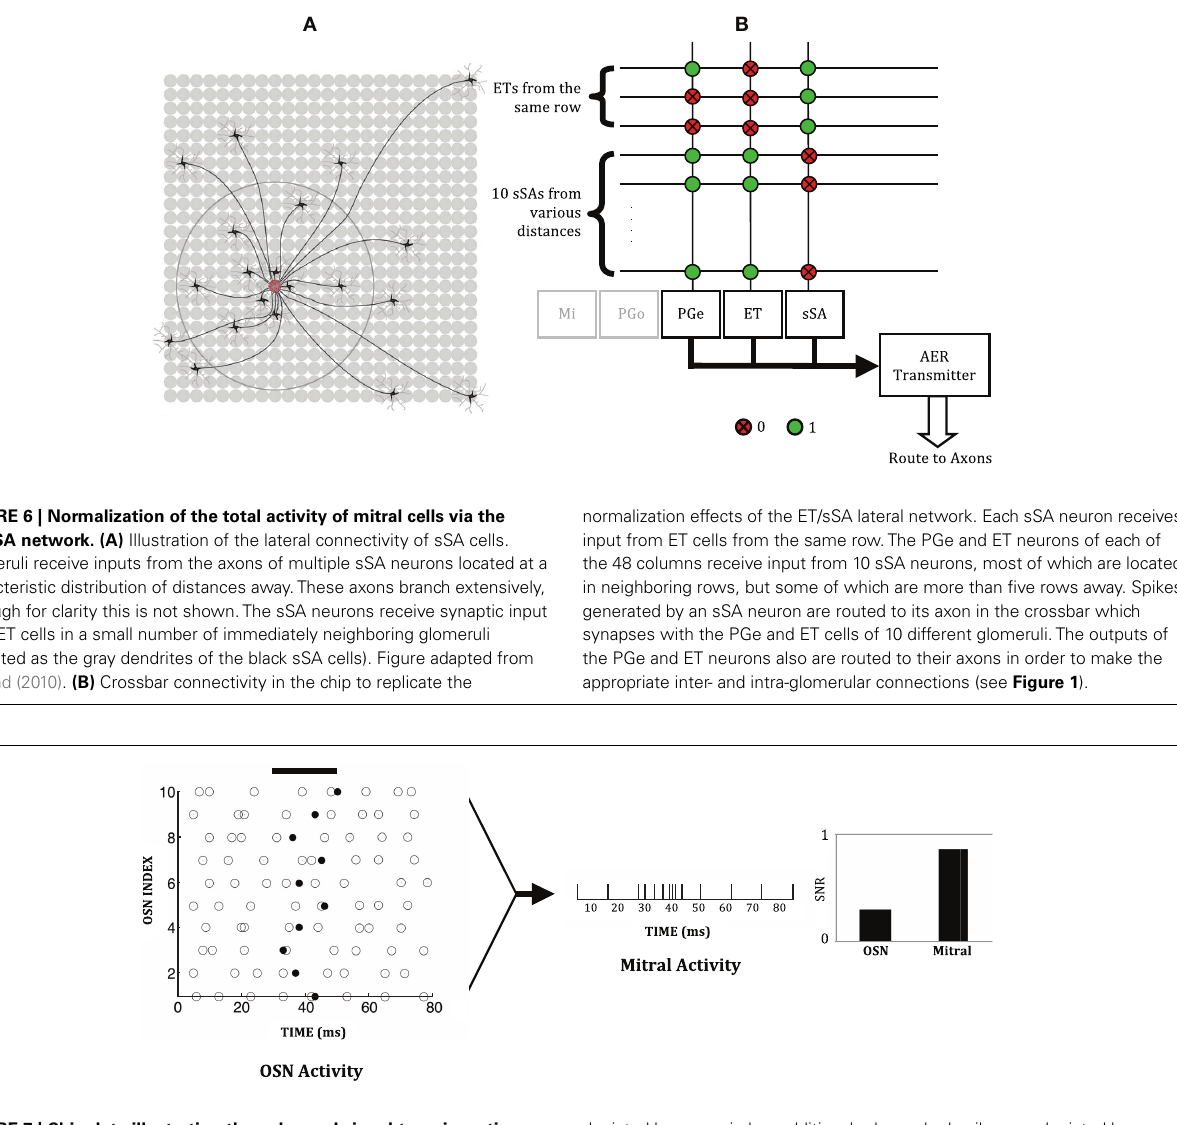
FIGURE 7 | Chip data illustrating the enhanced signal-to-noise ratio (SNR) in a mitral cell compared to an OSN. A constant low-concentration odor was presented between 30 and 50ms (solid black line).This increases the spiking probability of individual OSNs during one time step (1ms) from 0.1 to 0.15. Background spiking is